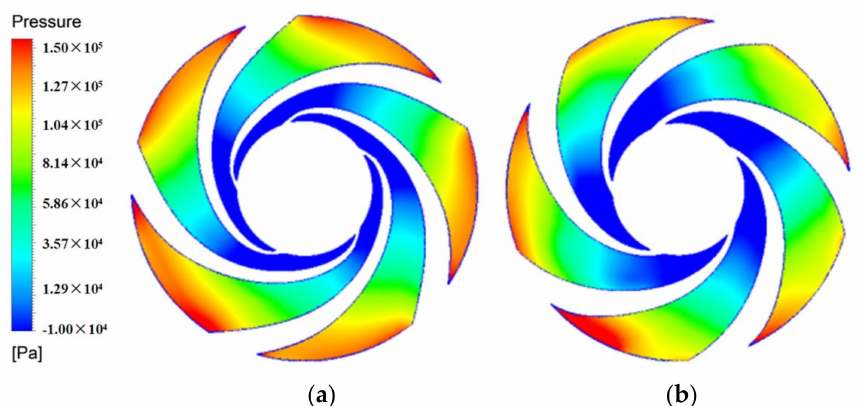
Figure 14. Impeller meridian plane of 5-blades pump of ( a ) scheme 11 and ( b ) scheme 25.